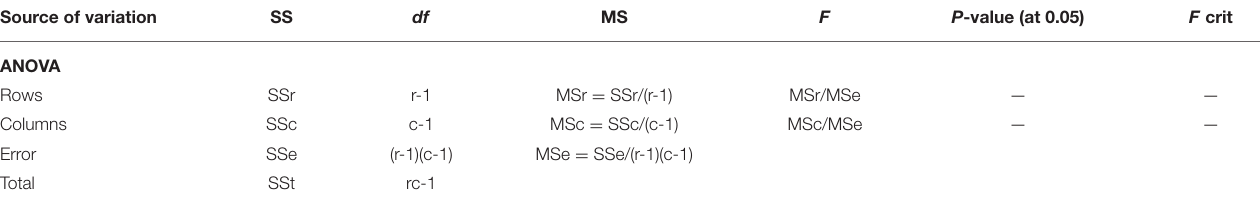
TABLE 2 | ANOVA (two-rowed without replication) layout. Source of variation SS df MS F P -value (at 0.05) F crit